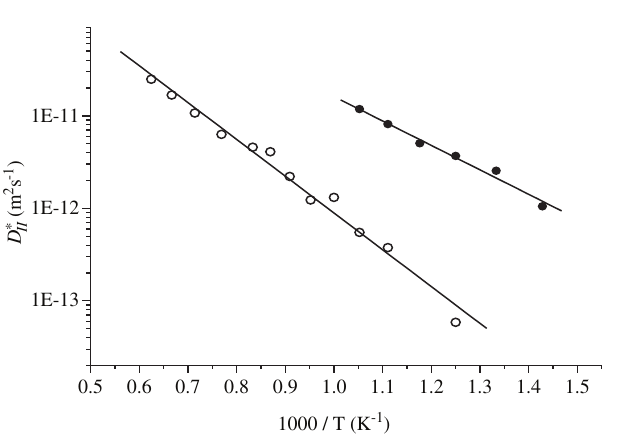
Figure 1. Atomic migration contribution to the diffusion coefficient D * and α -Hf (white circles).